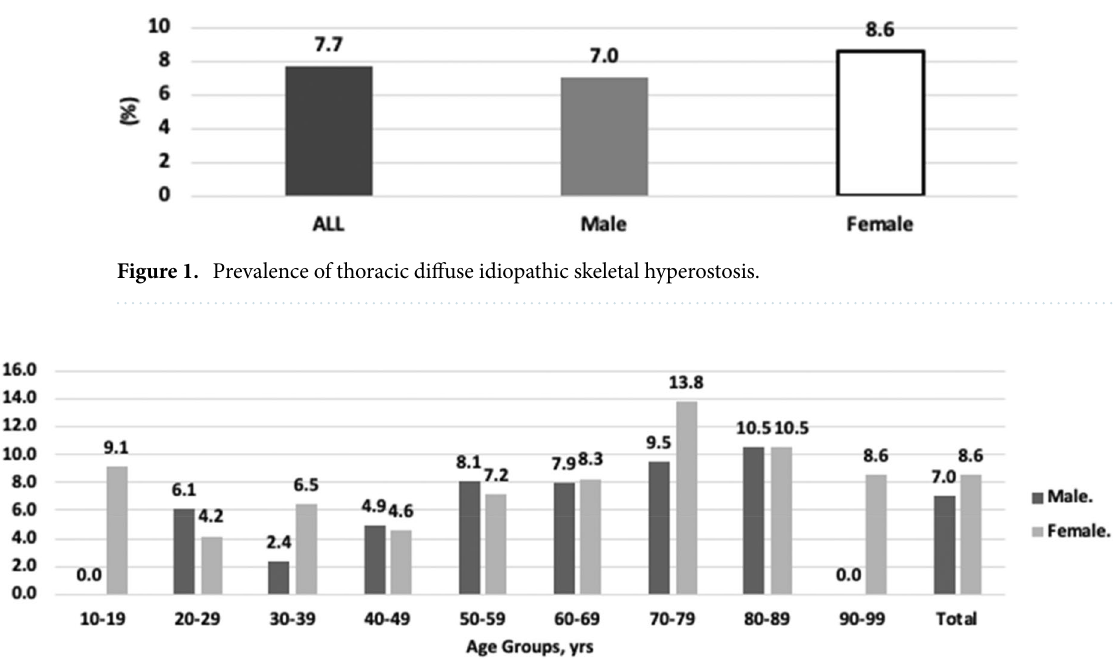
Figure 2. Age distribution of the prevalence of thoracic diffuse idiopathic skeletal